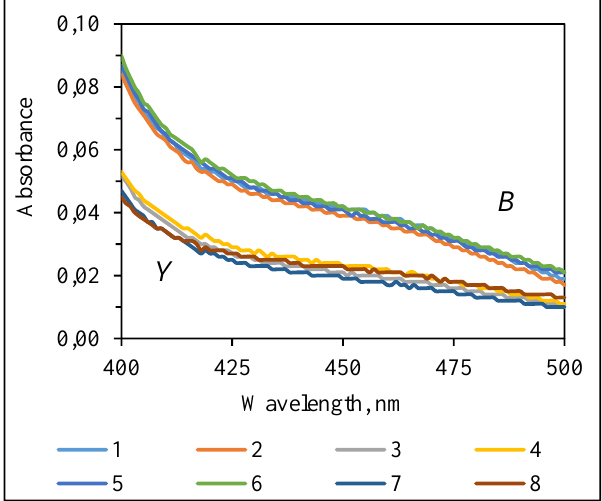
Figure 1. Fragments of the extracts spectra in the visible range: B – brown extracts in (1, 2, 5, 6); Y – yellow extracts (3, 4, 6,